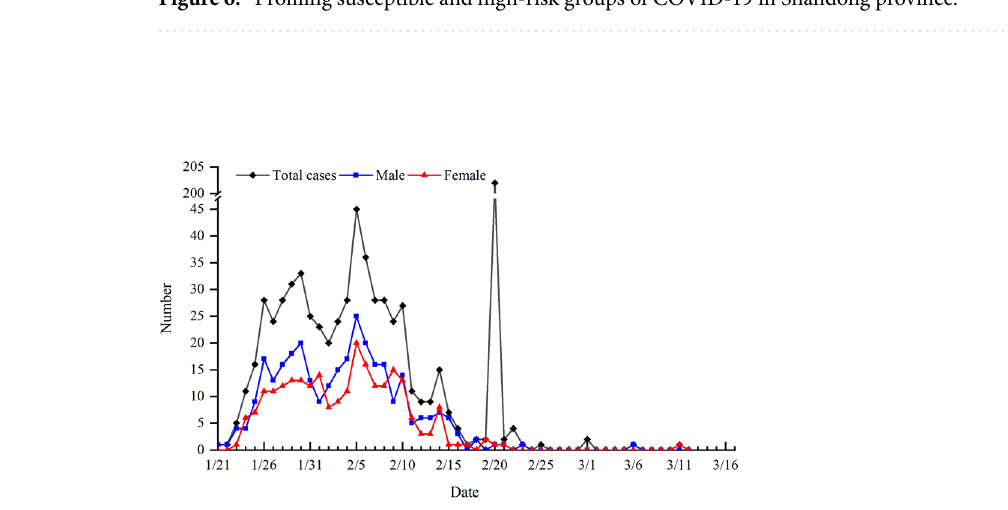
Figure 7. Change of the number of confirmed COVID-19 cases in Shandong